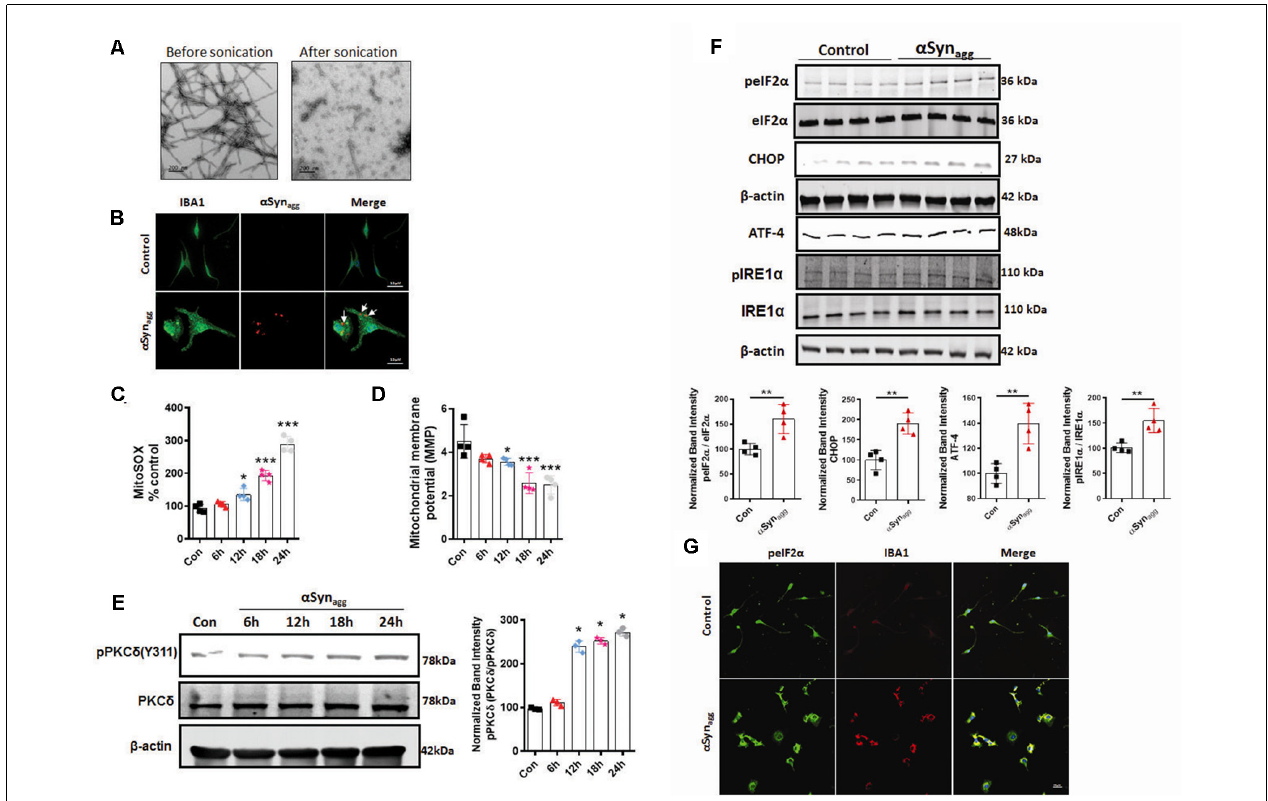
FIGURE 1 | Time-dependent mitochondrial dysfunction, PKC δ activation, and endoplasmic reticulum stress (ERS) markers in α Syn agg -stimulated mouse primary microglia. Mouse primary microglial cells were exposed to 1 µ M of α Syn agg for increasing durations (6, 12, 18, and 24 h) and mitochondrial superoxide generation was measured using MitoSOX dye-based spectrofluorometric analysis. (A) Generation of human preformed fibrils (PFF) α Syn and validation of uptake of α Syn agg by primary microglia. Representative scanning transmission electron microscopy (STEM) images of α Syn PFF before scale bar = 200 (nm) and after scale bar = 200 (nm) sonication. Even after sonication the α Syn PFF still retain their beta-sheet conformation. (B) Internalization of α Syn agg in primary microglia. Representative immunohistochemical images of mouse primary microglia depicting uptake of hu- α Syn as determined using antibodies against human α Syn (red) and microglial marker-IBA-1 (green) in primary microglia treated with α Syn agg for 1 h. Internalized human α Syn, visualized as red intracellular puncta), Scale bars, 15 µ m. (C) MitoROS generation increased in a time-dependent manner in α Syn agg -treated mouse primary microglia cells. Data shown are the mean ± SEM from at least